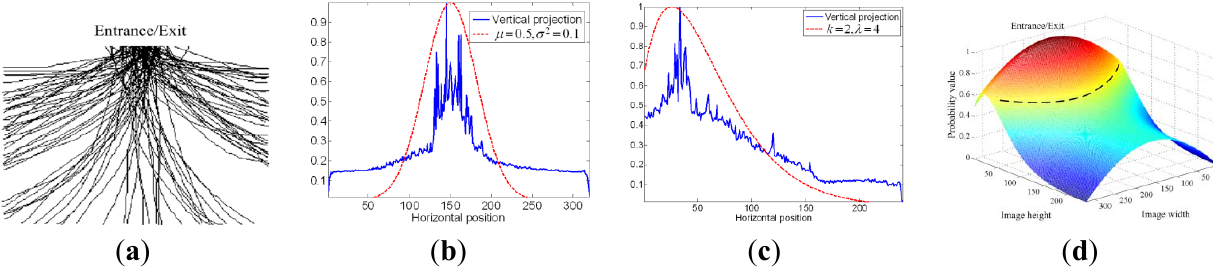
Vertical and horizontal projections are conducted to obtain the corresponding 1D histograms s for x and y respectively, and is indicated by the blue lines in Figure c c